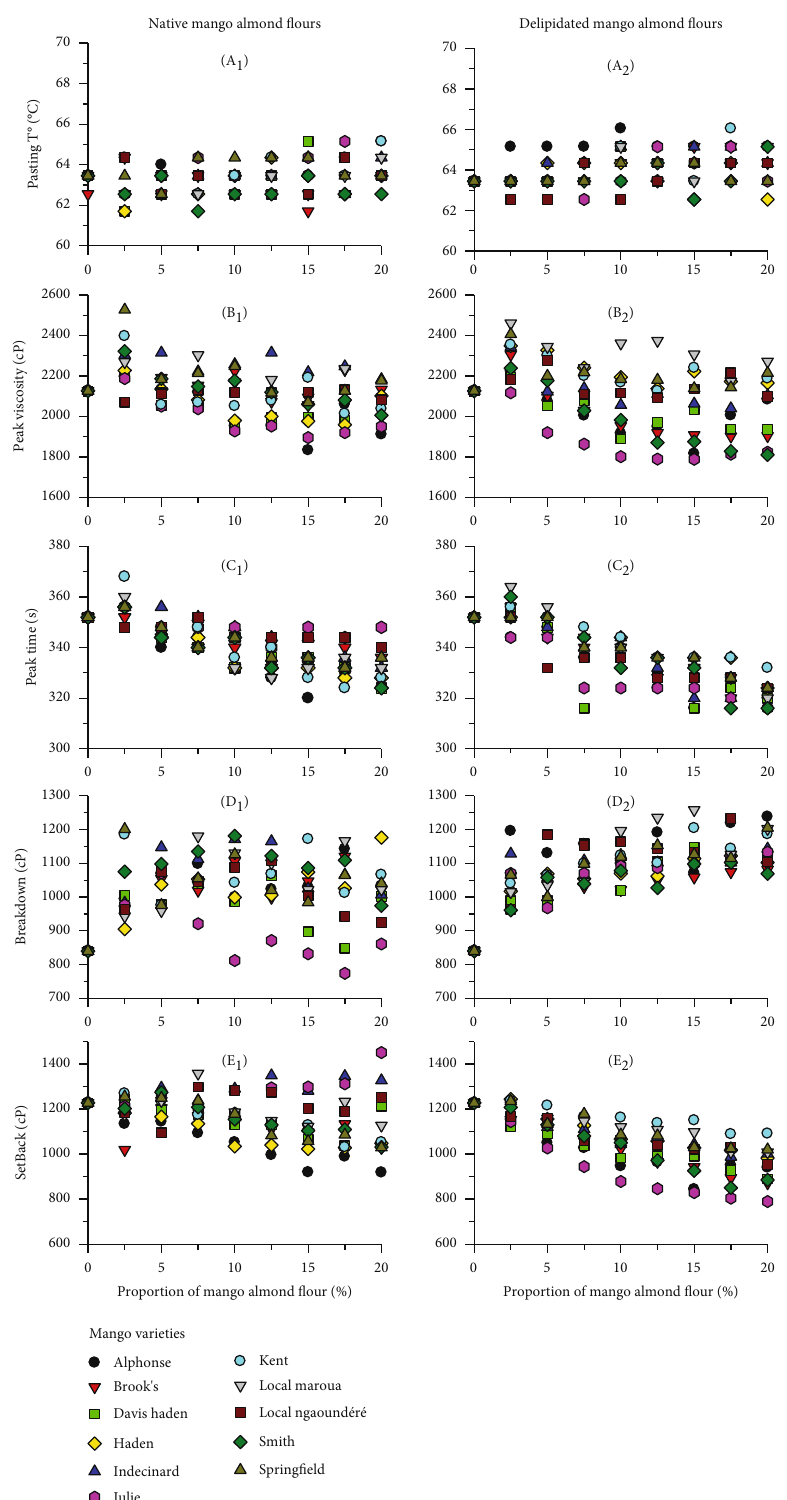
Figure 2: Pasting behavior of wheat fl our partially substituted with mango almond fl ours from di ff erent mango